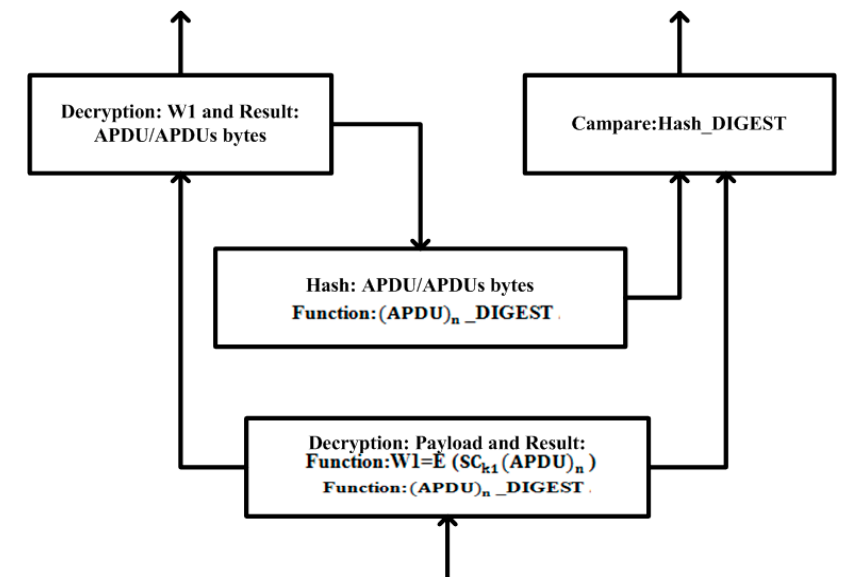
Figure 8. Decryption process: application-layer implementation.